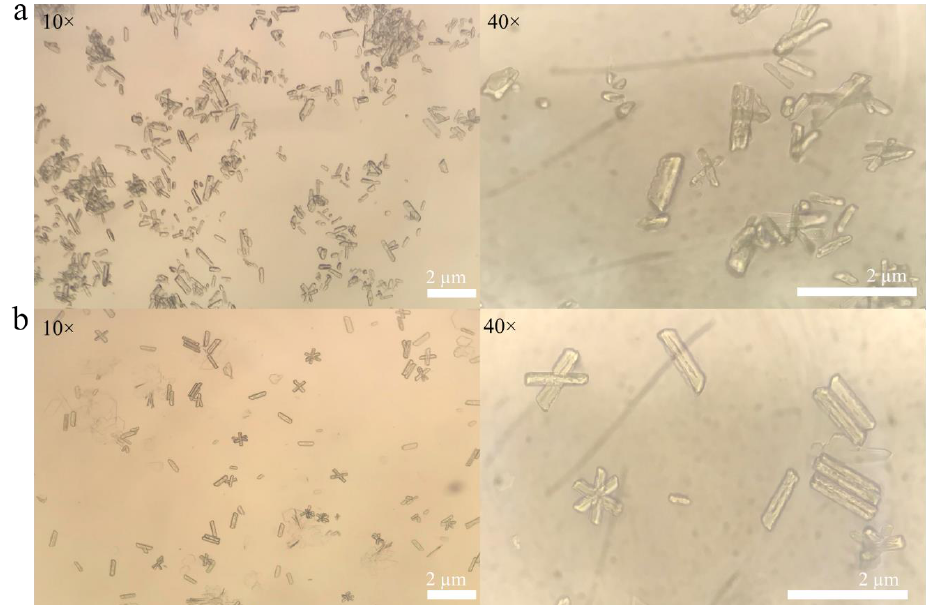
Figure 5. Microscopy images (at 10 × and 40 × magnifications) of struvite crystals formed from synthetic urines ( a ) before and ( b ) after the photocatalytic process (using 1% Sr-doped TiO 2 photocatalyst).